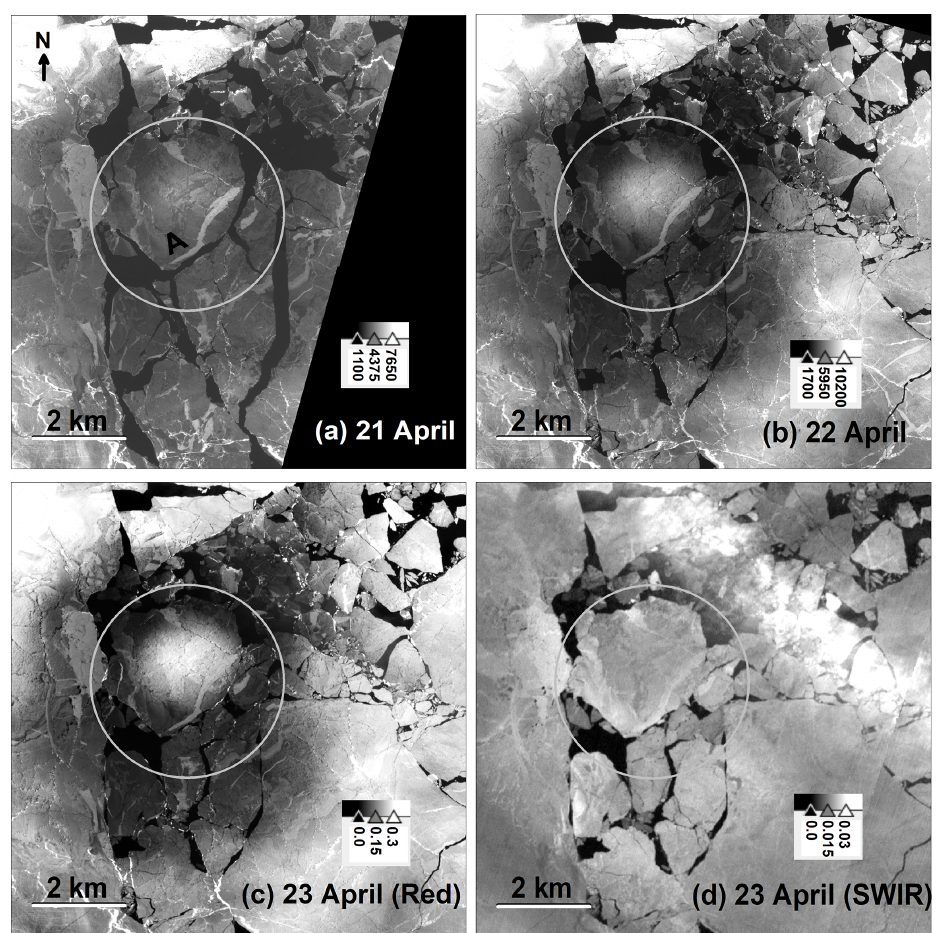
Figure 7. Same as Fig. 5, but (a) 21 April and (b) 22 April – PlanetScope, red band, (c) 23 April, Sentinel-2A, red band, (d) same image as (c) but SWIR band. A – large ice floe mentioned in the text. White linear features – cracks, black areas – open water. Colour stretching is different for each image to enhance the contrast. Grey palette – reflectance units (digital numbers), specific for each satellite and band. Projection UTM 48N.